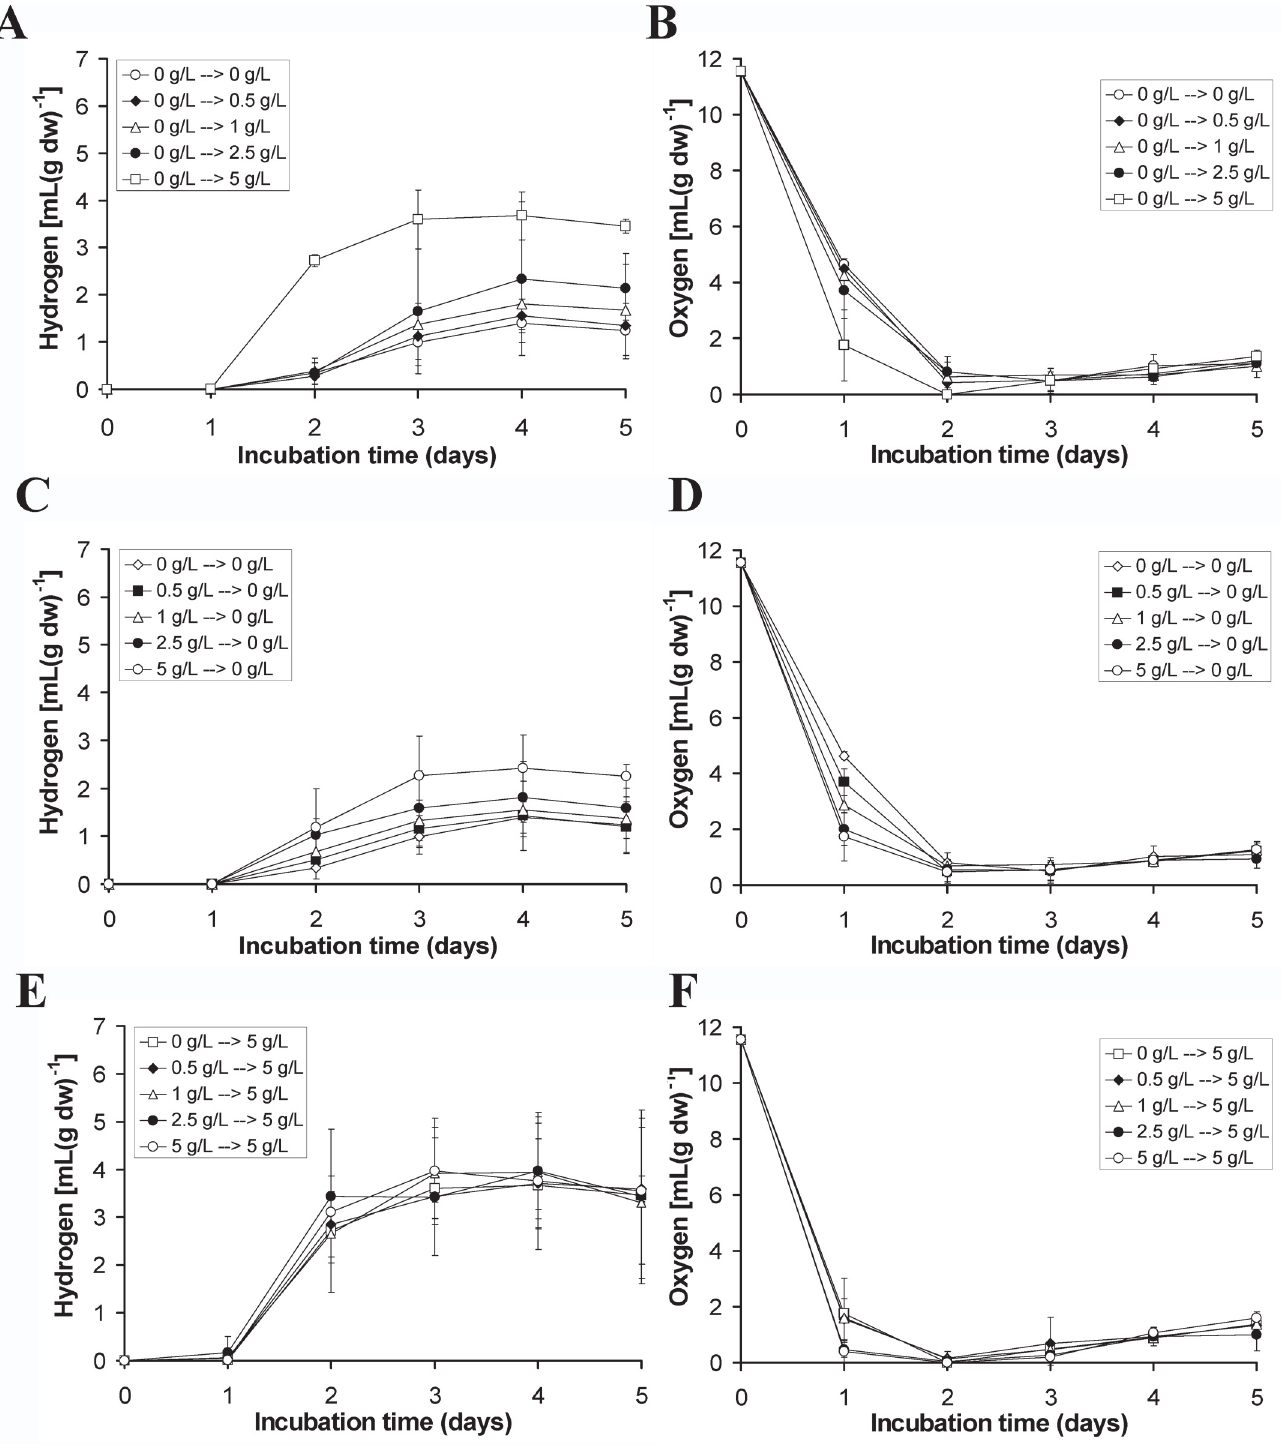
Fig 2. Kinetics of hydrogen production and oxygen consumption in the lichen Pleurosticta acetabulum . (A) and (B) regeneration in deionized water (no addition of glucose) and culture medium with 0, 0.5, 1.0, 2.5 or 5.0 g L -1 glucose. (C) and (D) regeneration in 0, 0.5, 1.0, 2.5 or 5.0 g L -1 glucose and culture medium without glucose. (E) and (F) regeneration in 0, 0.5, 1.0, 2.5 or 5.0 g L -1 glucose and culture medium with 5 g L -1 glucose.